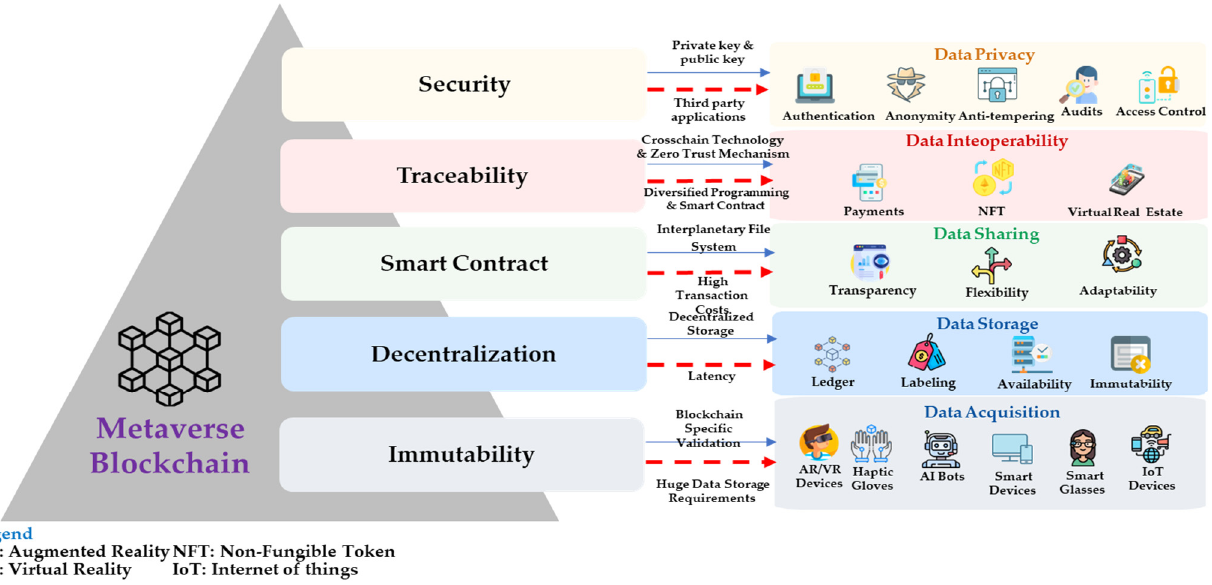
Figure 14. Blockchain for technical aspects in metaverse.